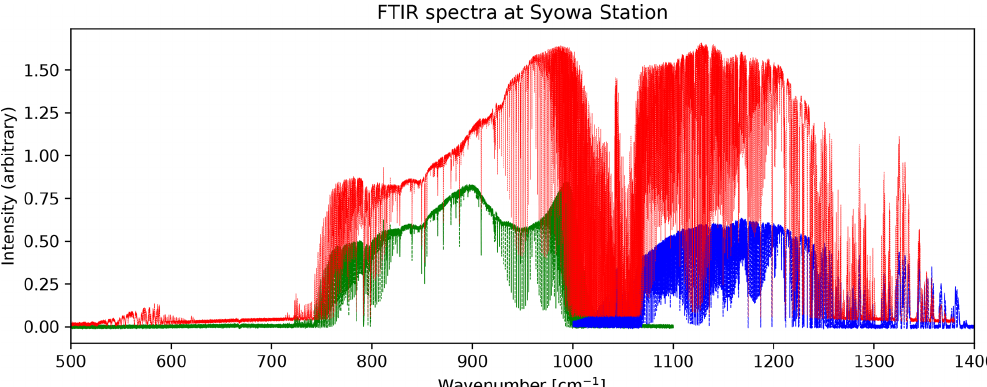
Figure 1. Examples of solar absorption spectra taken from FTIR observations at Syowa Station. The red spectrum was obtained with the filter no. 6 on 30 September 2007. The green and the blue ones were measured with filter no. 7 and no. 8 on 30 September 2011, respectively. A positive zero-level offset is clearly seen in the red filter no. 6 spectrum.